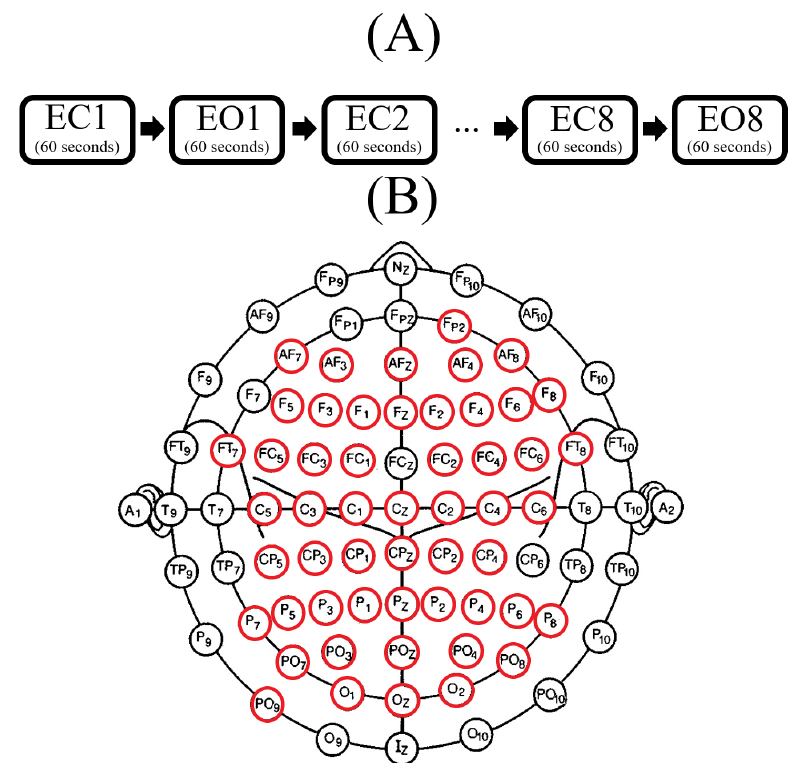
Figure 1. ( A ) Resting-state EEG acquisition protocol in mind–body–brain dataset [53]. It comprised 16 blocks where these blocks (60-s each) were divided into two settings: Eyes-Closed (EC) and Eyes-Open (EO). Each setting consisted of 8 blocks. These EC and EO blocks were interleaved and the recording started with EC for all participants. In this figure, the numbers 1 through 8 refer to the corresponding EC/EO block number. ( B ) Fifty-three EEG channels (circled in red) that were commonly available in all participants’ preprocessed EEG recordings. These channels were FP2, AF7, AF3, AFZ, AF4, AF8, C5, C3, C1, Cz, C2, C4, C6, CP5, CP3, CP1, CPZ, CP2, CP4, F5, F3, FZ, F1, F2, F4, F6, F8, FT7, FC5, FC3, FC1, FC2, FC4, FC6, FT8, P7, P5, P3, P1, PZ, P2, P4, P6, P8, PO9, PO7, POZ, PO3, PO4,